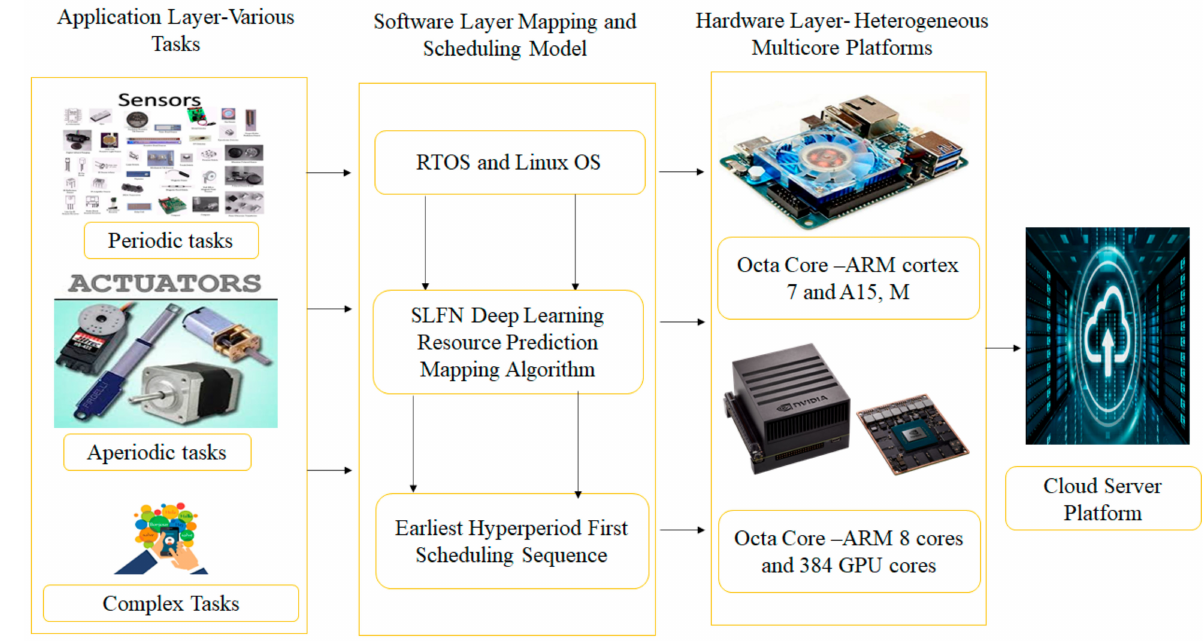
Figure 3. Overview structure of Proposed Intelligent